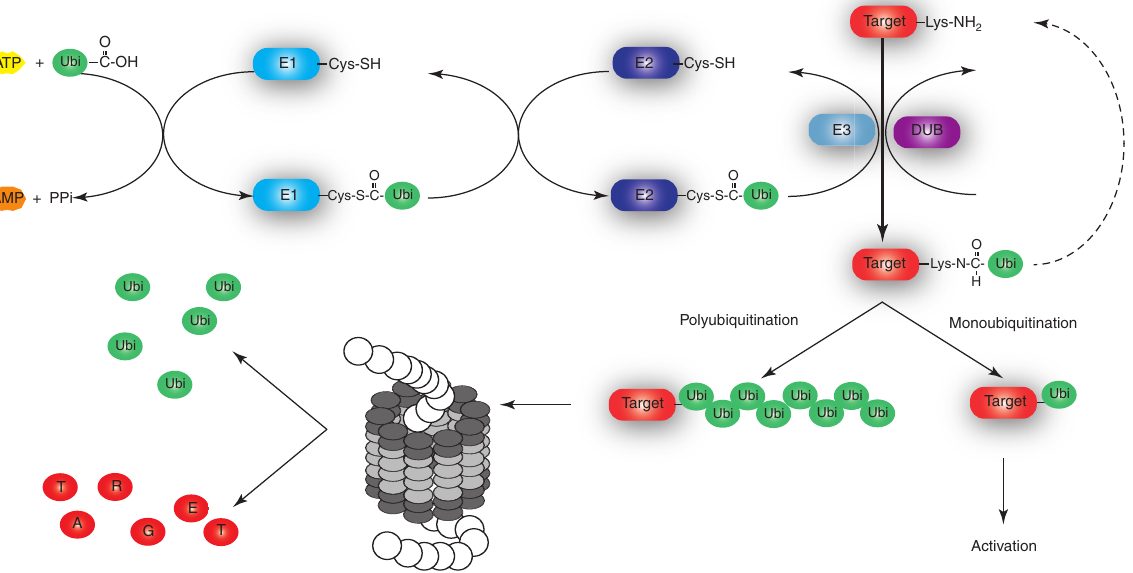
Figure 3: The ubiquitin proteasome system (UPS) is a highly regulated network which plays an important role in muscle catabolism. Conjugation of ubiquitin (Ubi) to substrate proteins involves three classes of enzymes: ubiquitin activating enzyme (E1), ubiquitin conjugat- ing enzyme (E2), and ubiquitin ligases (E3). The cleavage of ubiquitin from proteins and other molecules is catalyzed by deubiquitinating enzymes (DUB). Ubi conjugation may occur in different modes (poly-Ubi or mono-Ubi) and a subset is recognized by the 26S proteasome. Modified from ref.